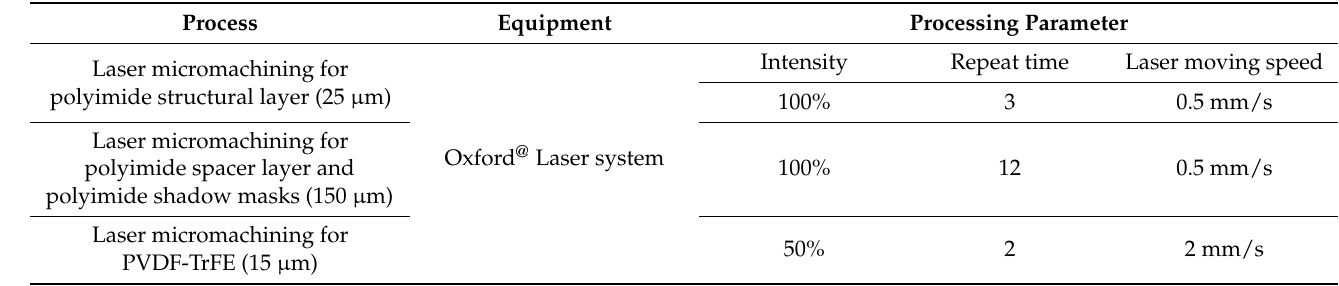
Table 3. Equipment and processing parameters to fabricate MEMS test